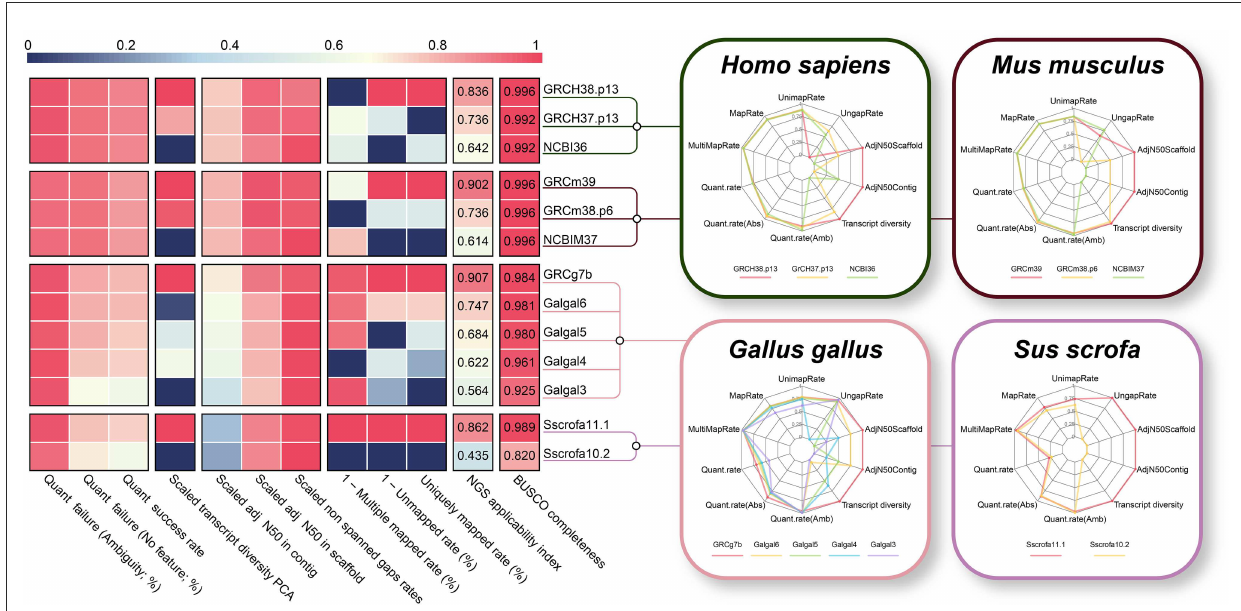
FIGURE7 Technical validation of the NGS applicability index based on the different genome builds. Comparison between NGS applicability index and BUSCO completeness for different version of reference genome and gene annotation. Polygonal charts represent values for each of the 10 effective indicators that make up the NGS applicability index. The larger the polygon area represent the higher the NGS applicability